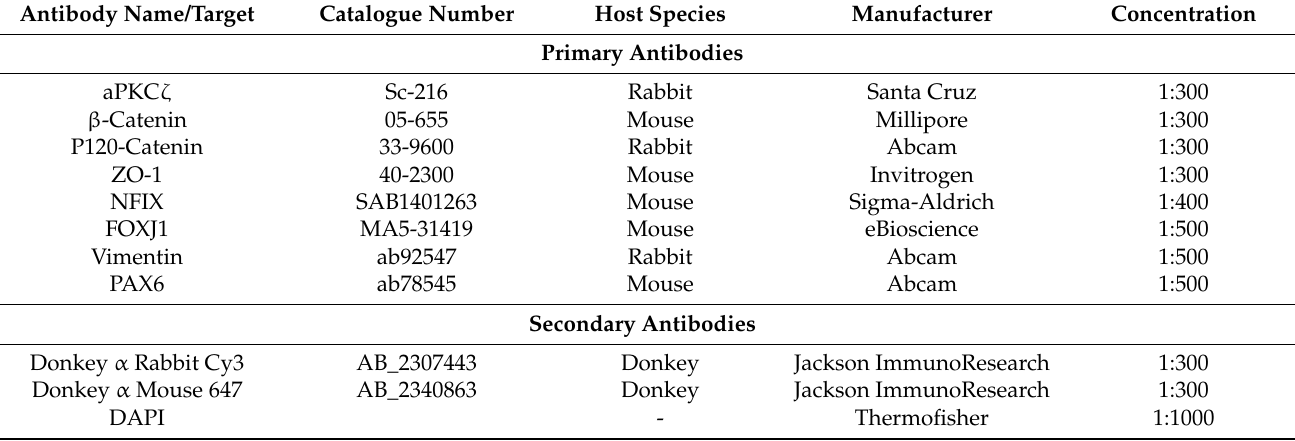
Table 1. Antibodies used in immunofluorescence histochemistry of fixed Nfix KO and Nfix iFOXJ1-GFP brain tissue sections. Table list the name, species, manufacturer and the concentration of use for each antibody. Antibody concentrations diluted in donkey